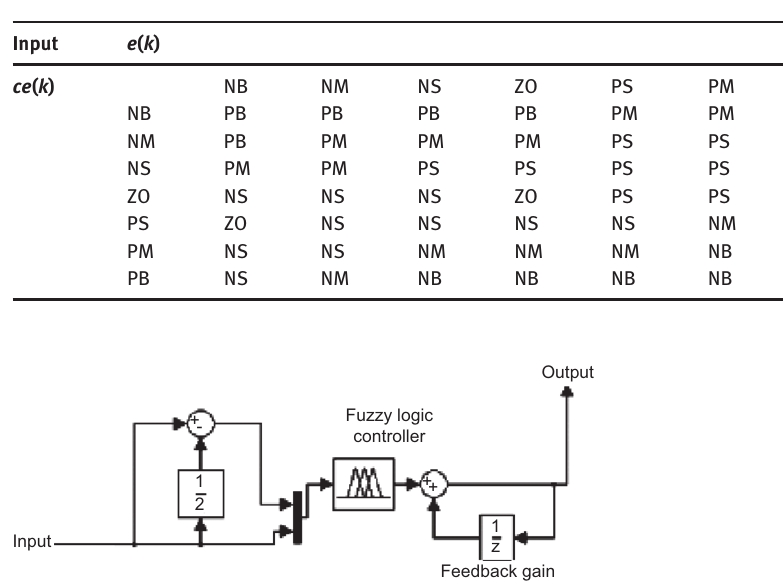
Table 1. FUZZY Inference Rule for Fuzzy Logic Controller.